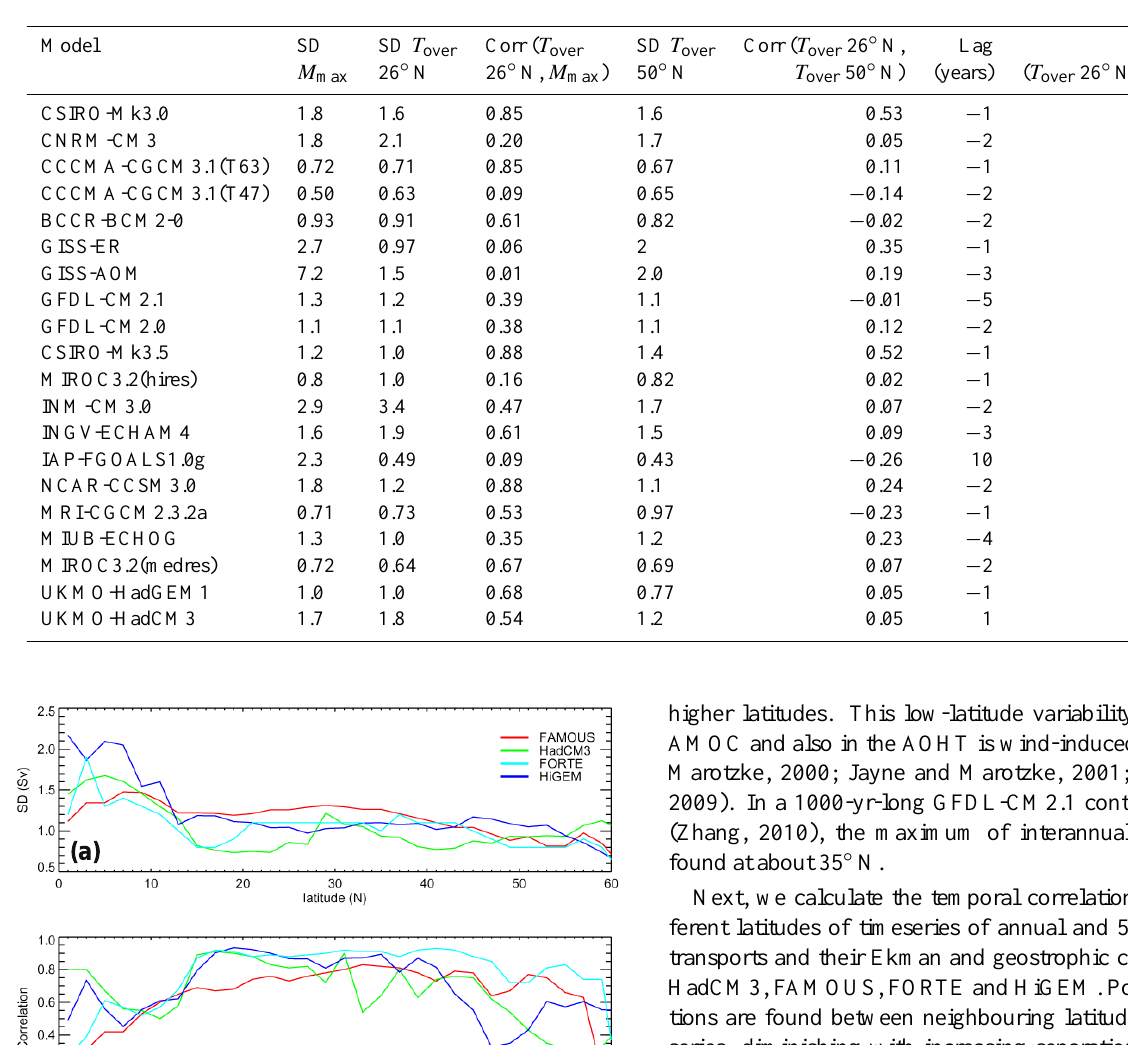
Table 2. Comparison of standard deviations (in Sv) of Atlantic MOC ( T over ) at 26 ◦ N, 50 ◦ N and of the maximum of Atlantic MOC, M max , and their correlations in the CMIP3 models. Linear or quadratic trend is removed for unsteady runs before the calculation. The lag between T over at 26 ◦ N and 50 ◦ N is shown which gives the largest correlation of their timeseries. The lag is negative when T over 26 ◦ N lags.